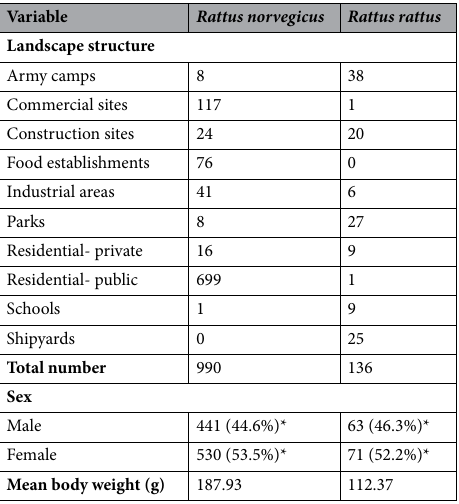
Table 1. Distribution of the captured Rattus rattus and Rattus norvegicus across the urban landscape and basic characteristics of the rodents. *Some rodents have incomplete data; sex of rodents was not determined for 19 Rattus norvegicus and 2 Rattus rattus .